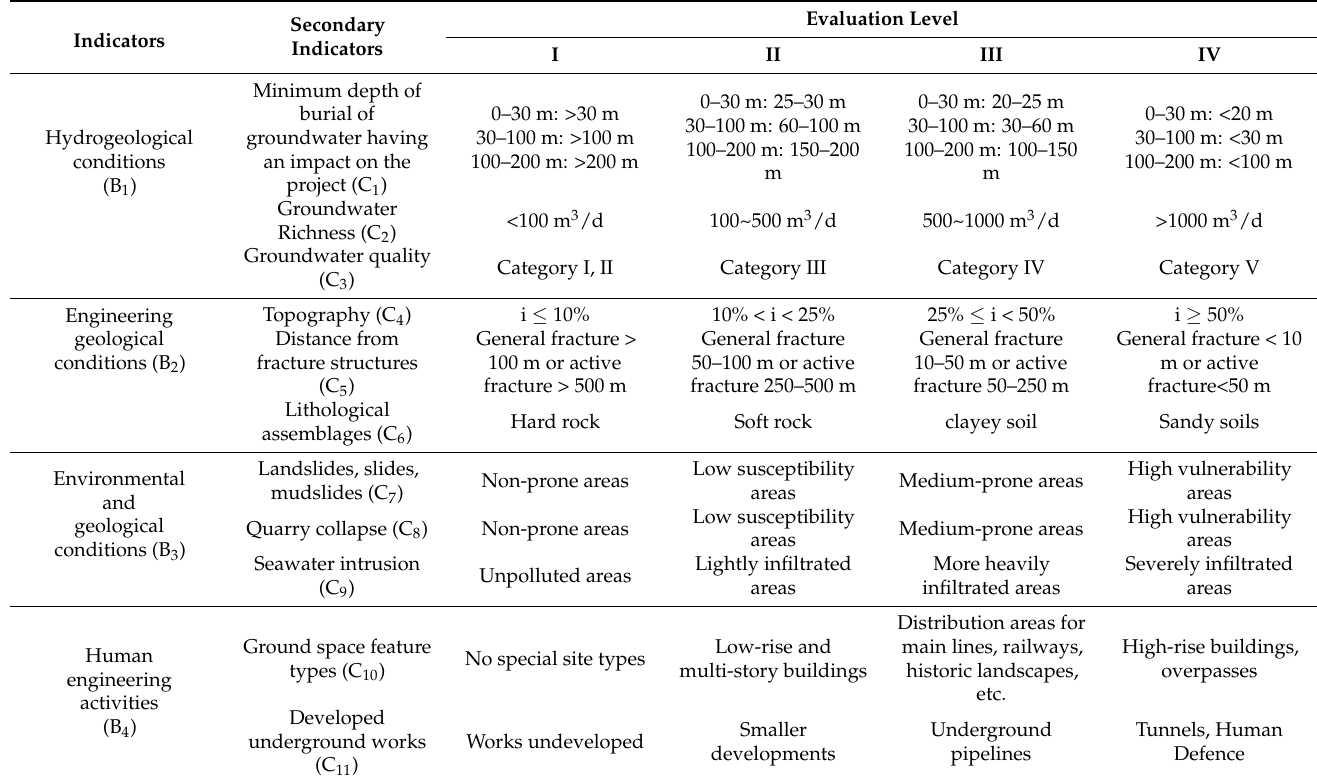
Table 1. Quantitative classification table of suitability evaluation index of underground space resources development in Weihai